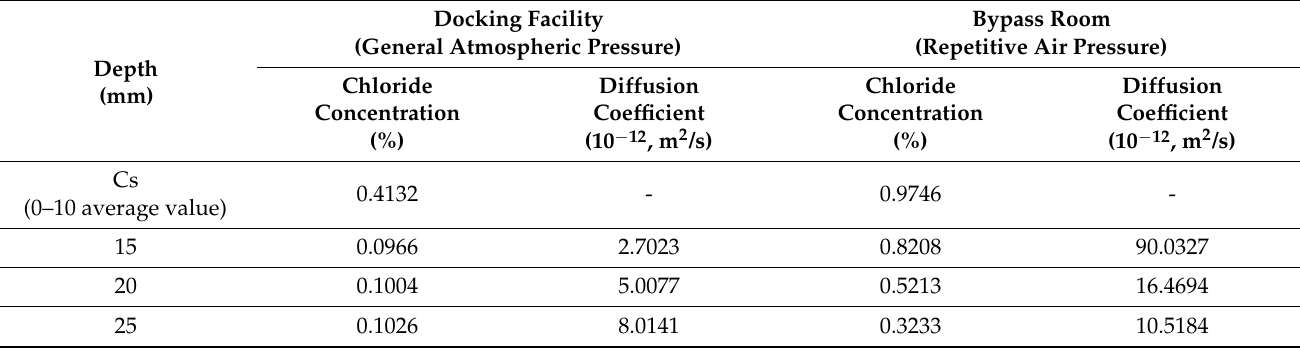
Table 7. Chloride concentration value and diffusion coefficient by